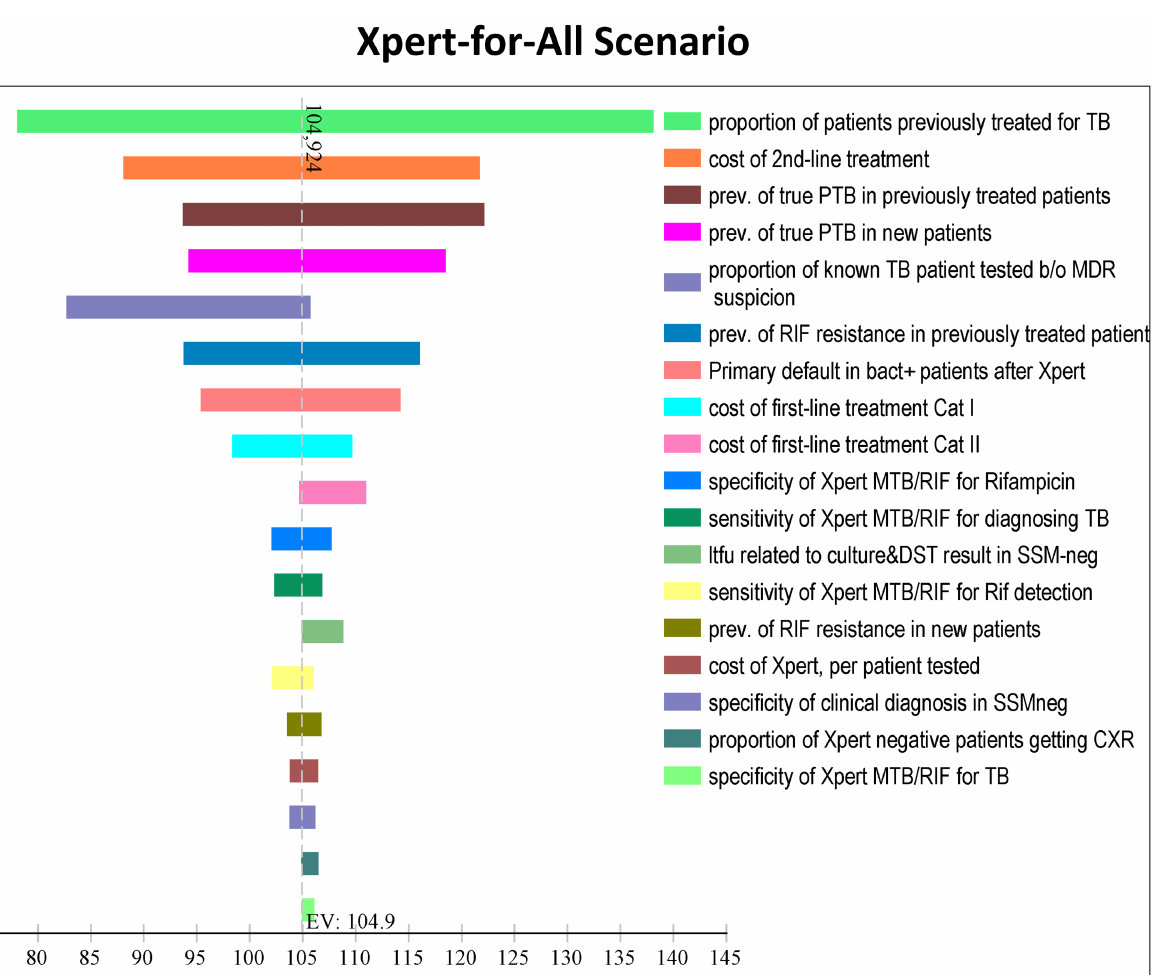
Fig 1. Tornado diagram showing the effect of variation in each parameter value on total costs (US$ per patient tested) for the Xpert for all scenario.